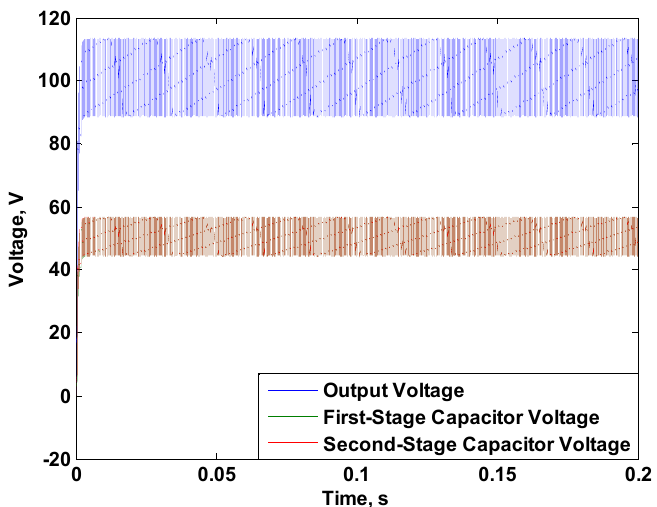
Figure 27. Output, first-stage capacitor and second-stage capacitor voltages when the converter is